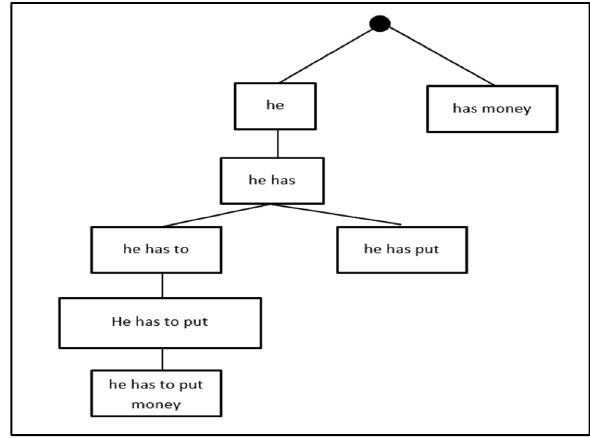
Figure 2. The CT illustration of Example 1.